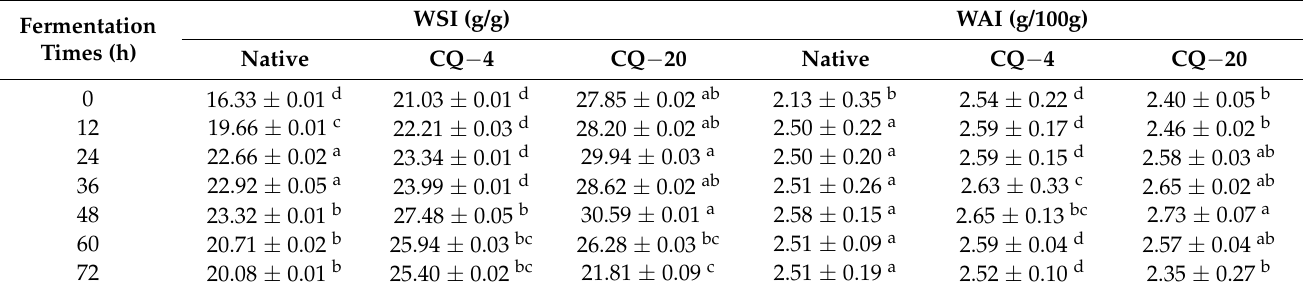
Table 2. Effect of different fermentation time after cold stress processes on the WAI and